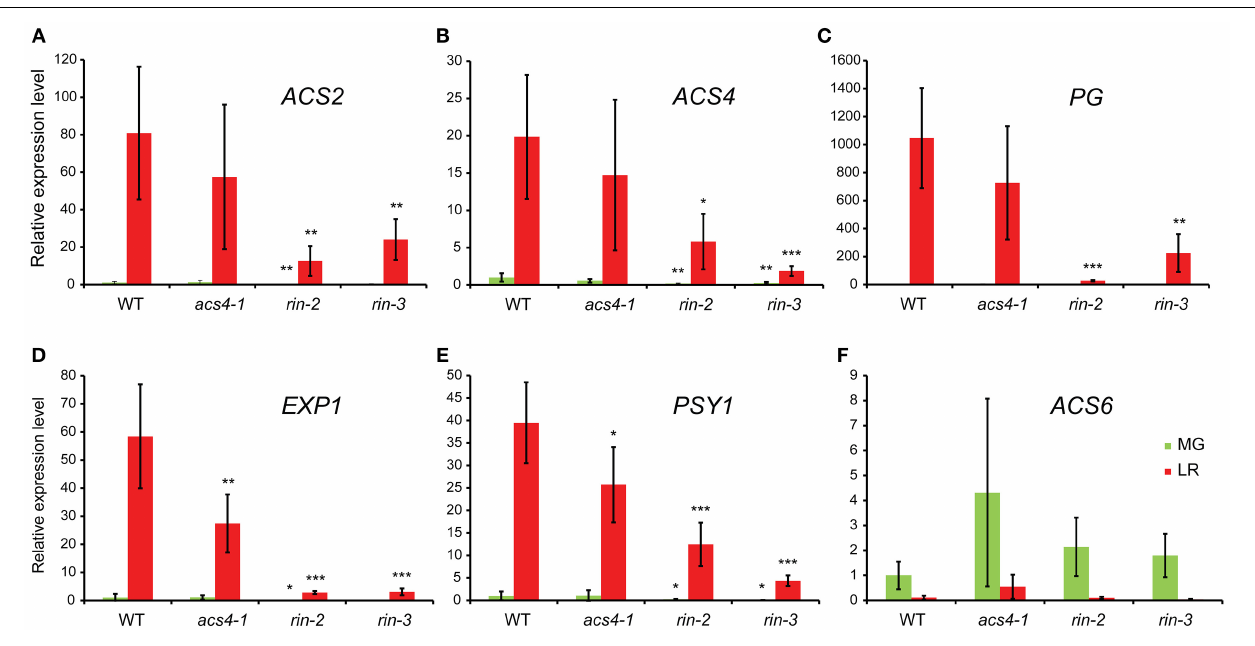
genotype in the green stage has been valued 1. Values represent the average of 3–6 biological replicates, ± SD . ∗ significantly different from the same stage in the wild type, P < 0 . 05; ∗∗ P < 0 . 01; ∗∗∗ P < 0 .